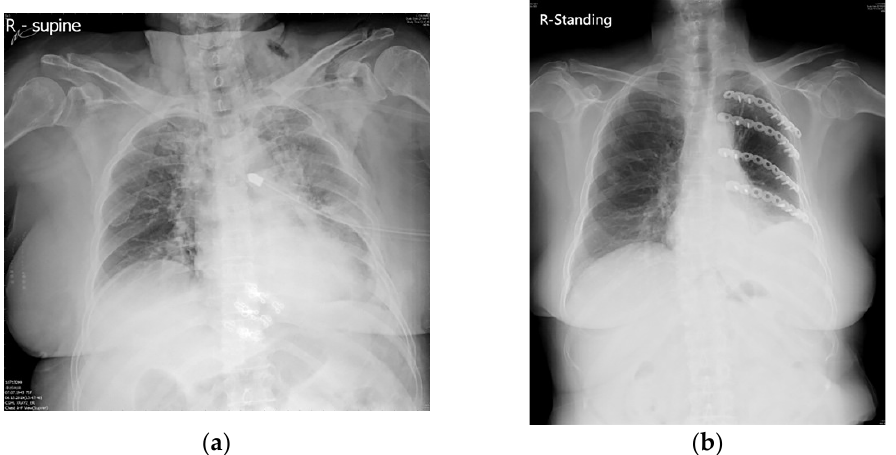
Figure 1. The posteroanterior chest plain films of the multiple ribs fracture of one geriatric patient. ( a ) Geriatric patient suffering from left multiple ribs fracture with hemothorax and chest tube insertion. ( b ) After rib fixation with plates, the thoracic cage was reconstructed and the lung expanded well. Preoperative evaluations such as fractured rib number, location, associated pulmo-